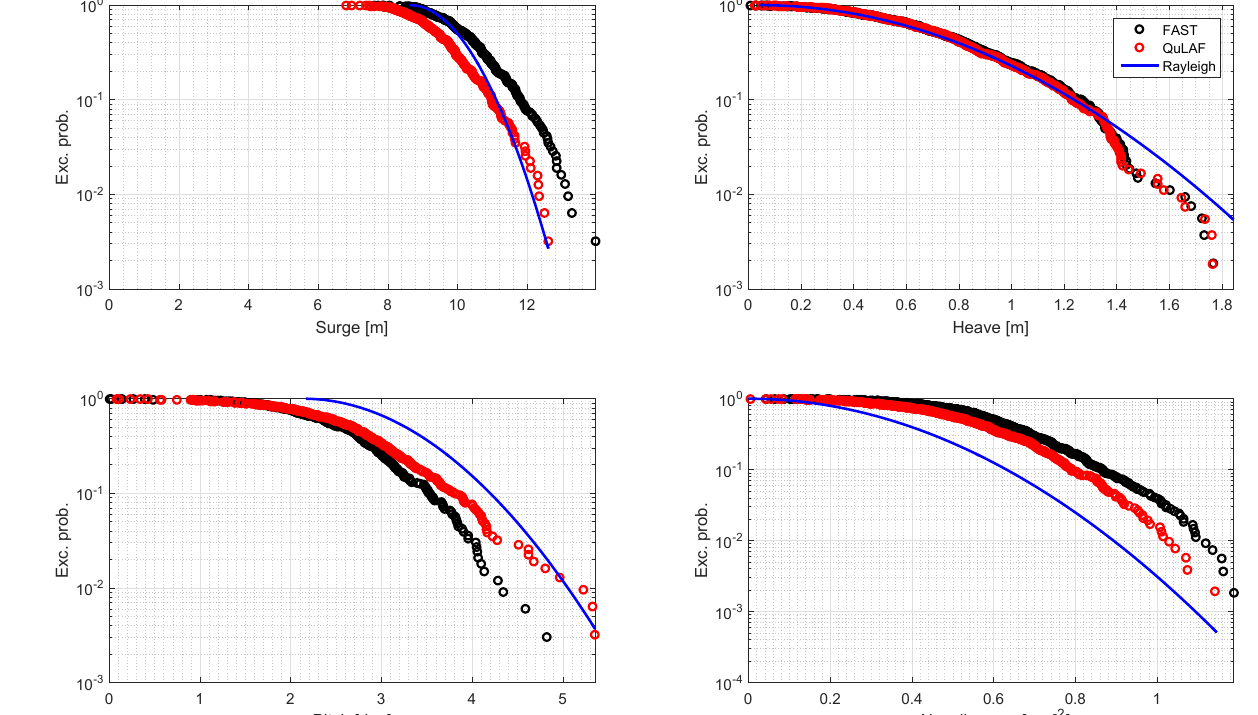
Figure 10. Exceedance probability of the response to irregular waves and turbulent wind.